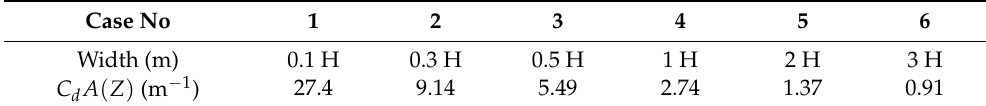
Table 1. Parameters for cases with different